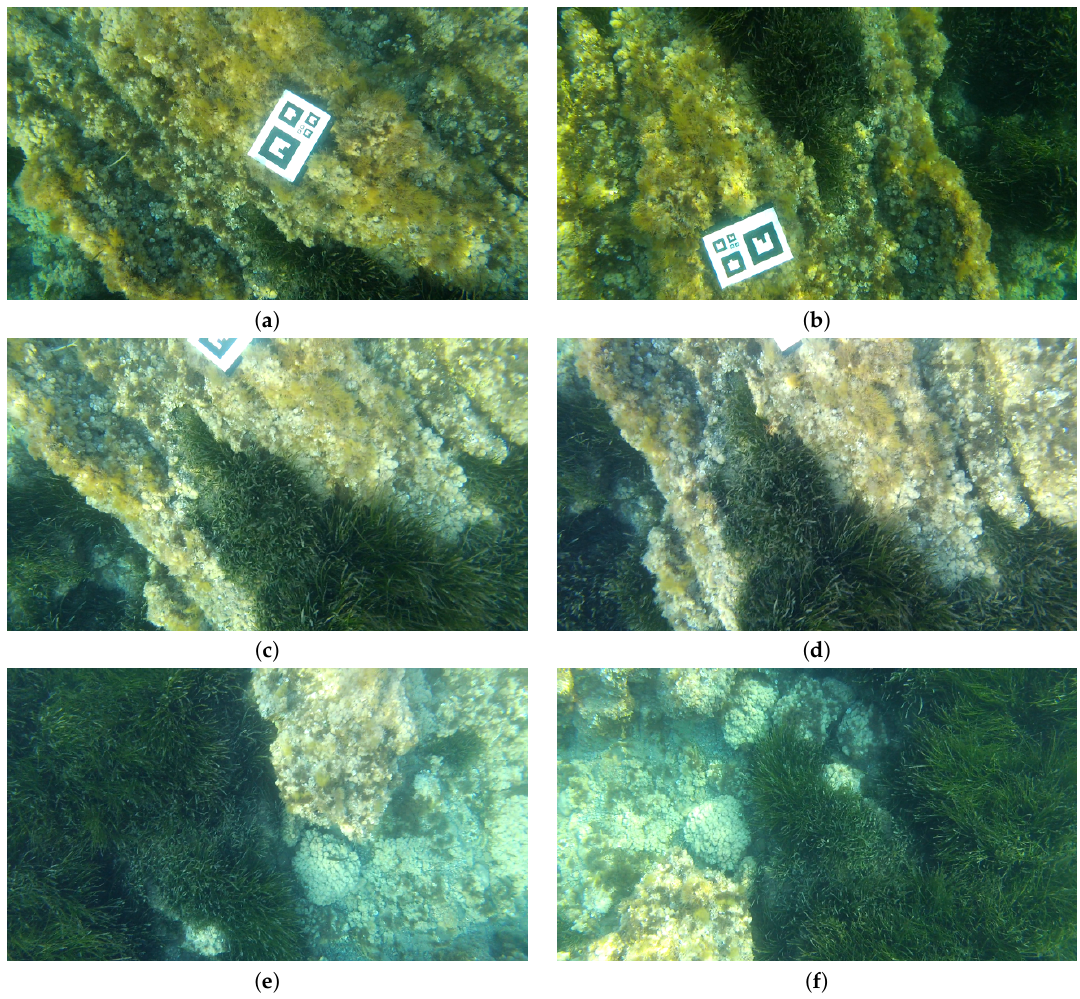
Figure 9. Multi-session loops between sequences V 1 and V 2: Each image in the left column closes a loop with the corresponding image in the right column. ( a , b ) Image 155 of Sequence V 1 with Image 2 of Sequence V 2. ( c , d ) Image 152 of Sequence V 1 with Image 195 of Sequence V 2. ( e , f ) Image 138 of Sequence V 1 with Image 28 of Sequence V